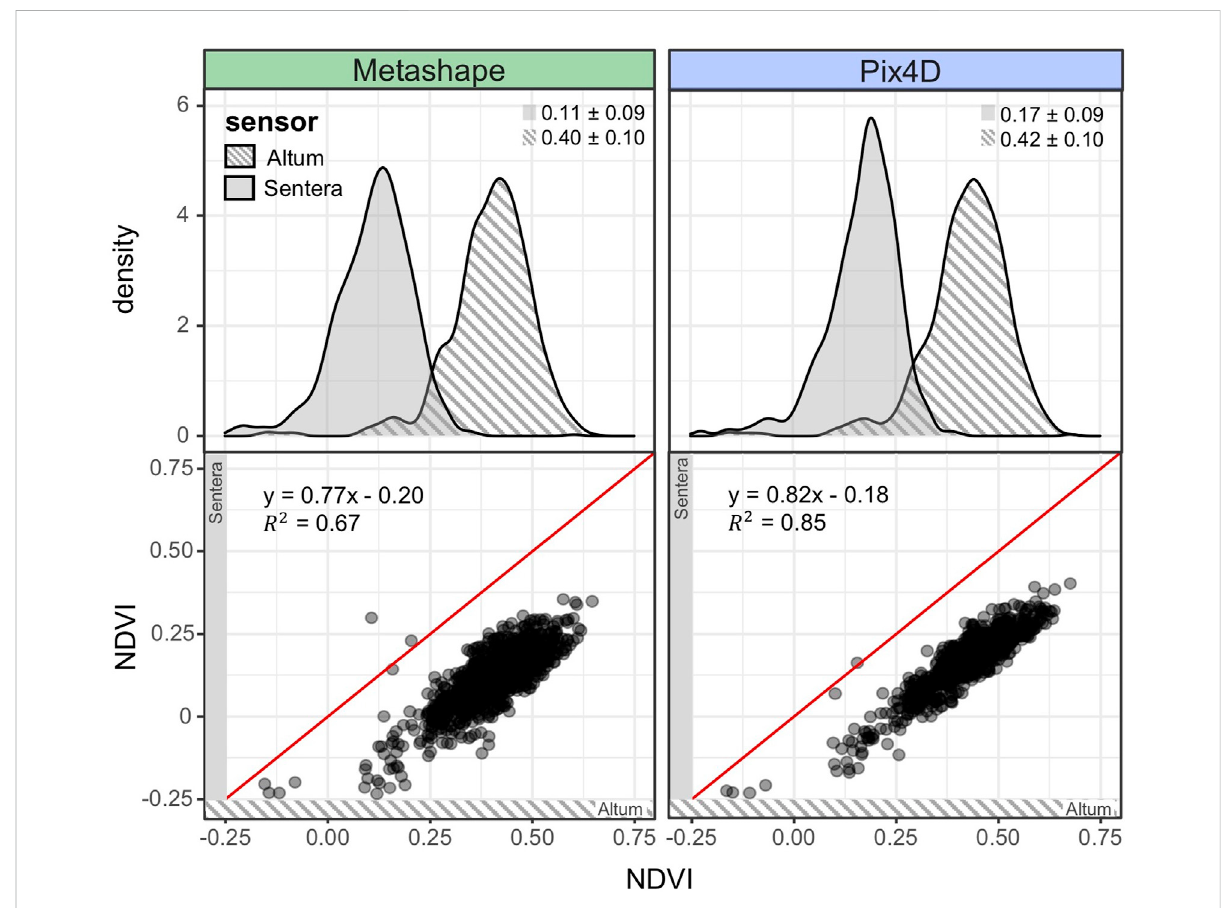
FIGURE 5 Multispectral sensors used in this analysis demonstrate different NDVI readings of the same area. Random 0.25 m 2 samples (n = 1,000) were generated across SfM-derived NDVI rasters and the mean NDVI value was compared across sensors and softwares.